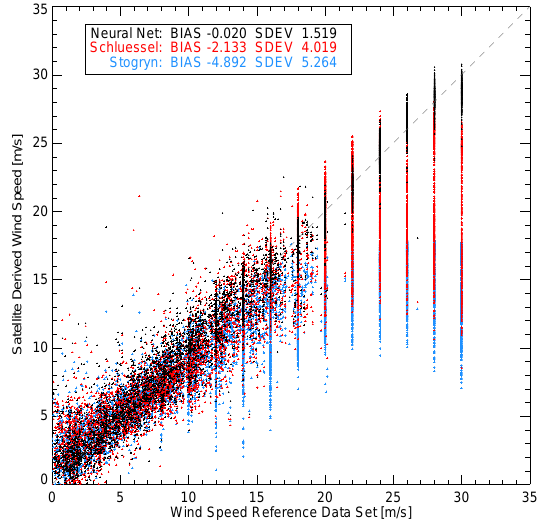
Figure 11. Comparison of the HOAPS-3 neural network wind speed retrieval (black), the algorithms of Schl¨ussel and Luthardt (1991) (red) and Stogryn et al. (1994) (blue) against the verifica- tion data set of the neural network algorithm. The verification data set contains wind speed measurements from buoys and radiosonde measurements. The latter are binned in 2m / s steps, resulting in dis- crete intervals for higher wind